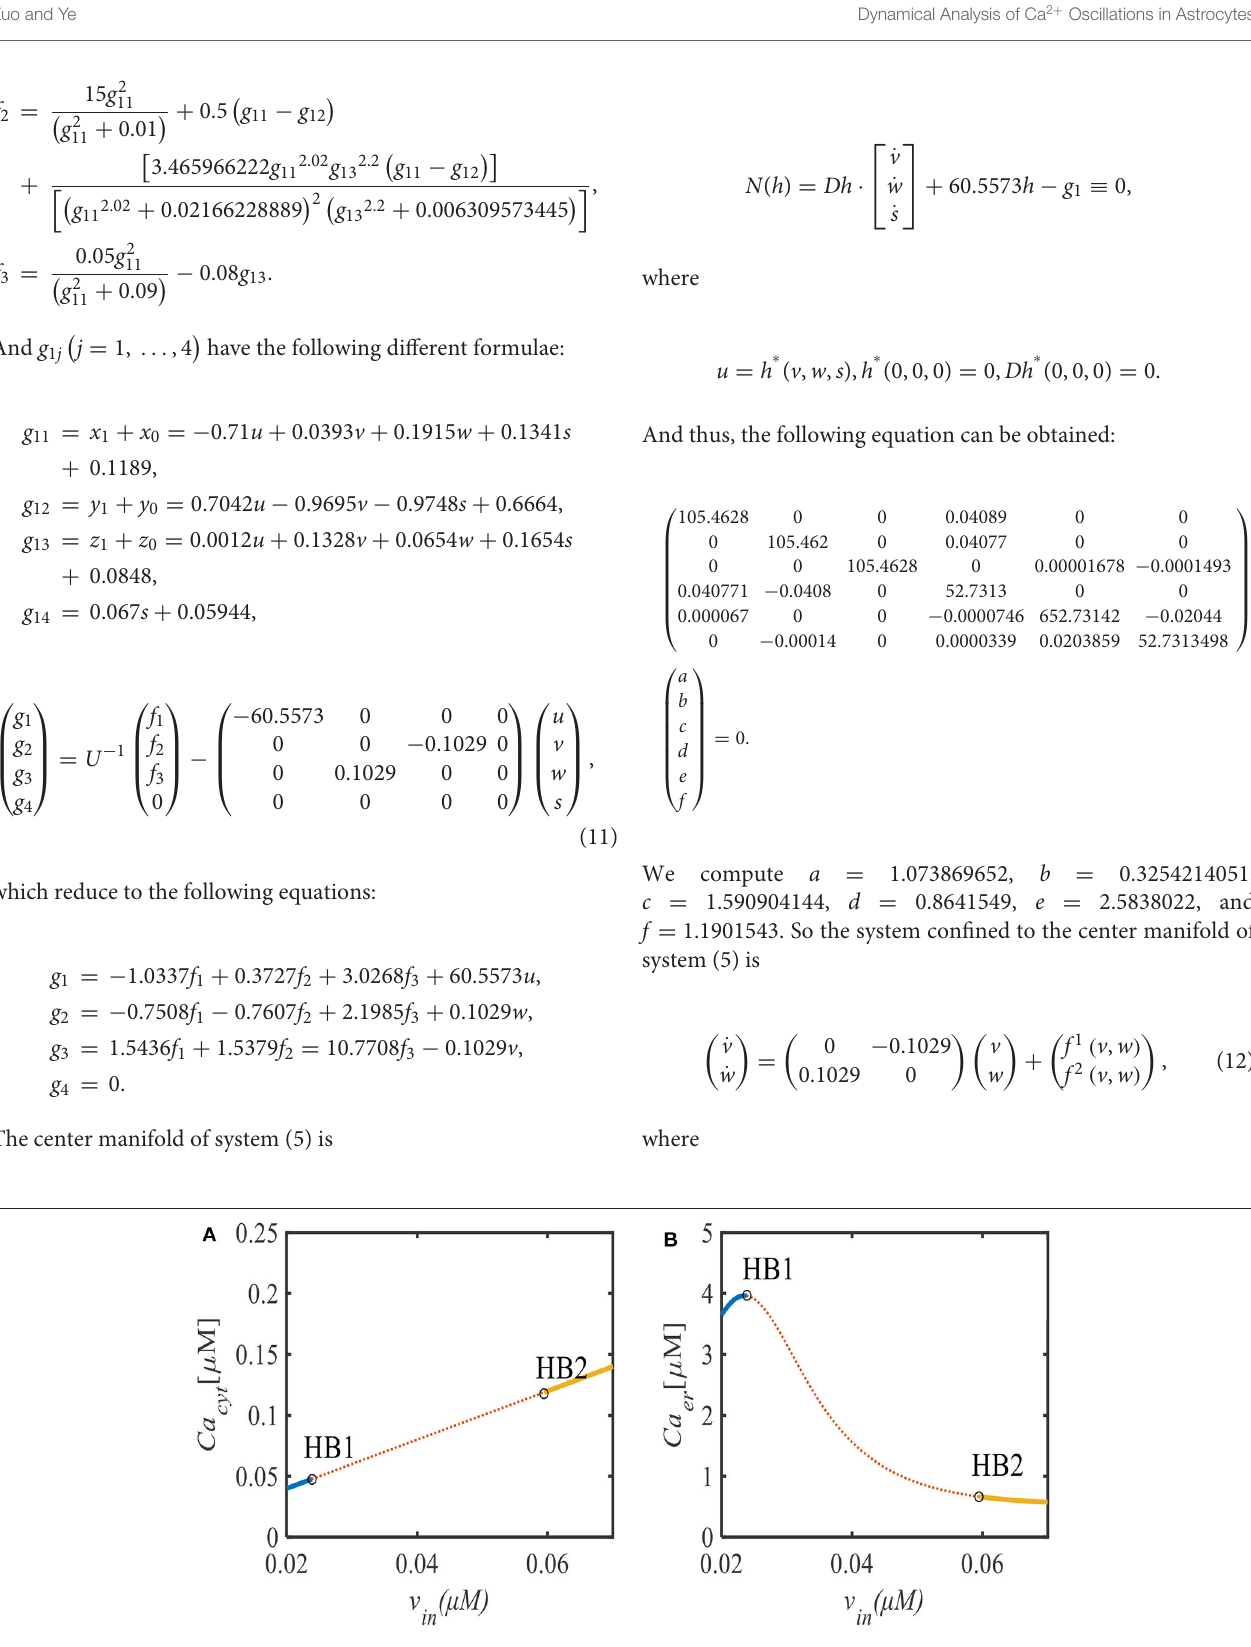
FIGURE 1 | (A) Bifurcation diagram of the equilibrium of system (2) in the ( v in , Ca cyt )-plane. (B) Bifurcation diagram of the equilibrium of system (2) in the ( v in , Ca er )-plane. Points HB1 and HB2 are the Hopf bifurcation